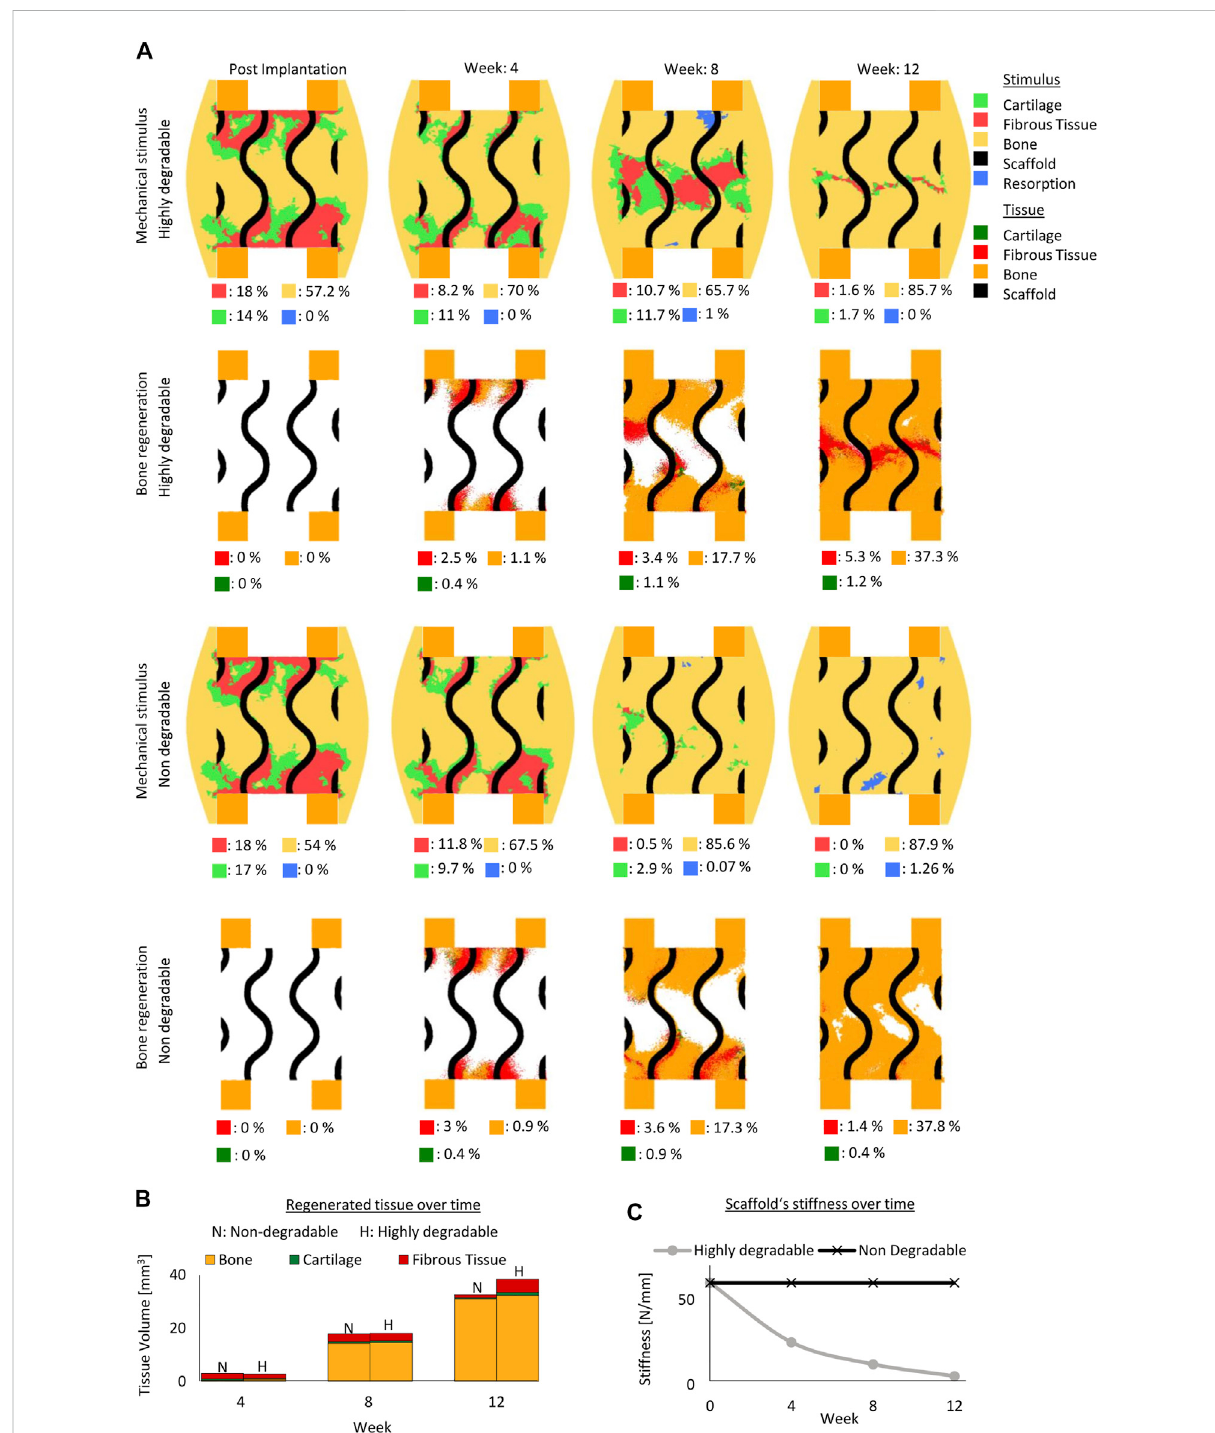
FIGURE 3 Predicted bone, cartilage and fi brous tissue within the scaffold pores at 4, 8 and 12 weeks of healing for scaffolds with non- and highly degradable scaffolds with 79% porosity. (A) : Longitudinal cross sections of the callus from Figure 1A with quanti fi ed tissue regeneration in the 2D section, mechanical stimulus distribution over time using a non-degradable scaffold, predicted tissue distribution over time using a non-degradable scaffold, mechanical stimulus distribution over time using a highly degradable and predicted tissue distribution over time using a highly degradable. (B) :Totaltissuevolumepredictedwithinthescaffoldporesatdifferentstagesofhealing. (C) :Mechanicalstiffnessofscaffoldscomputed from compression tests at different stages of